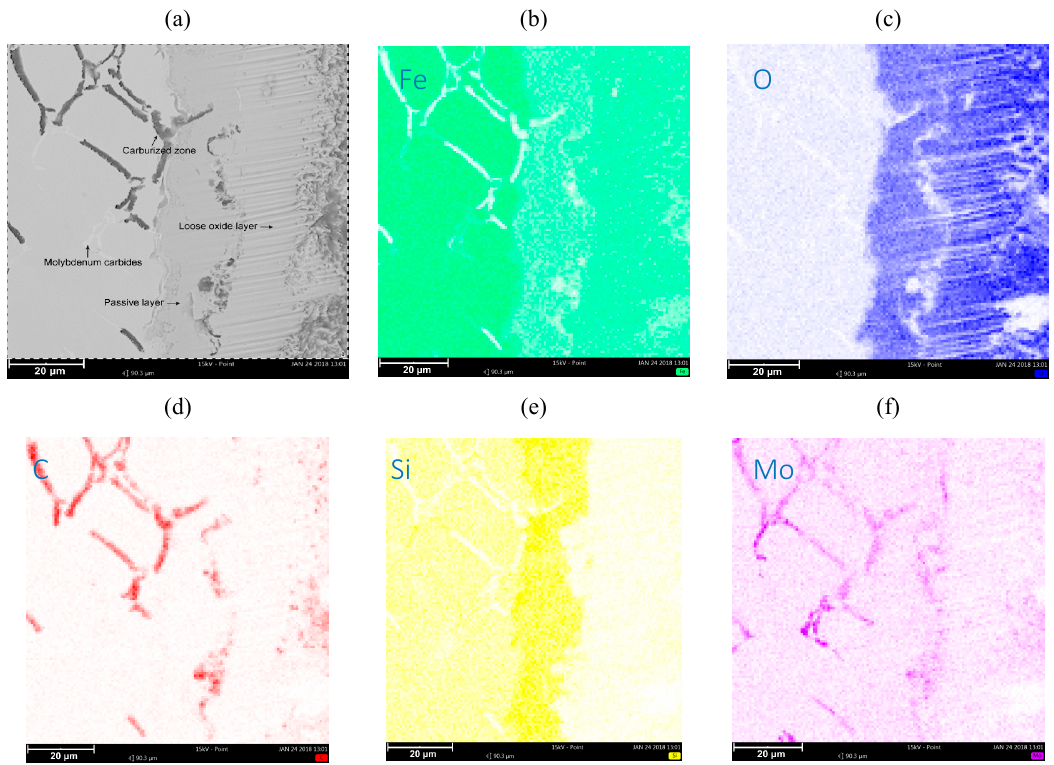
Figure 5. View of the carburized layer. SiMo sample 5. 2.51% Mo ( a ). Map for ( b ) Fe, ( c ) O, ( d ) C, ( e ) Si, and ( f ) Mo.